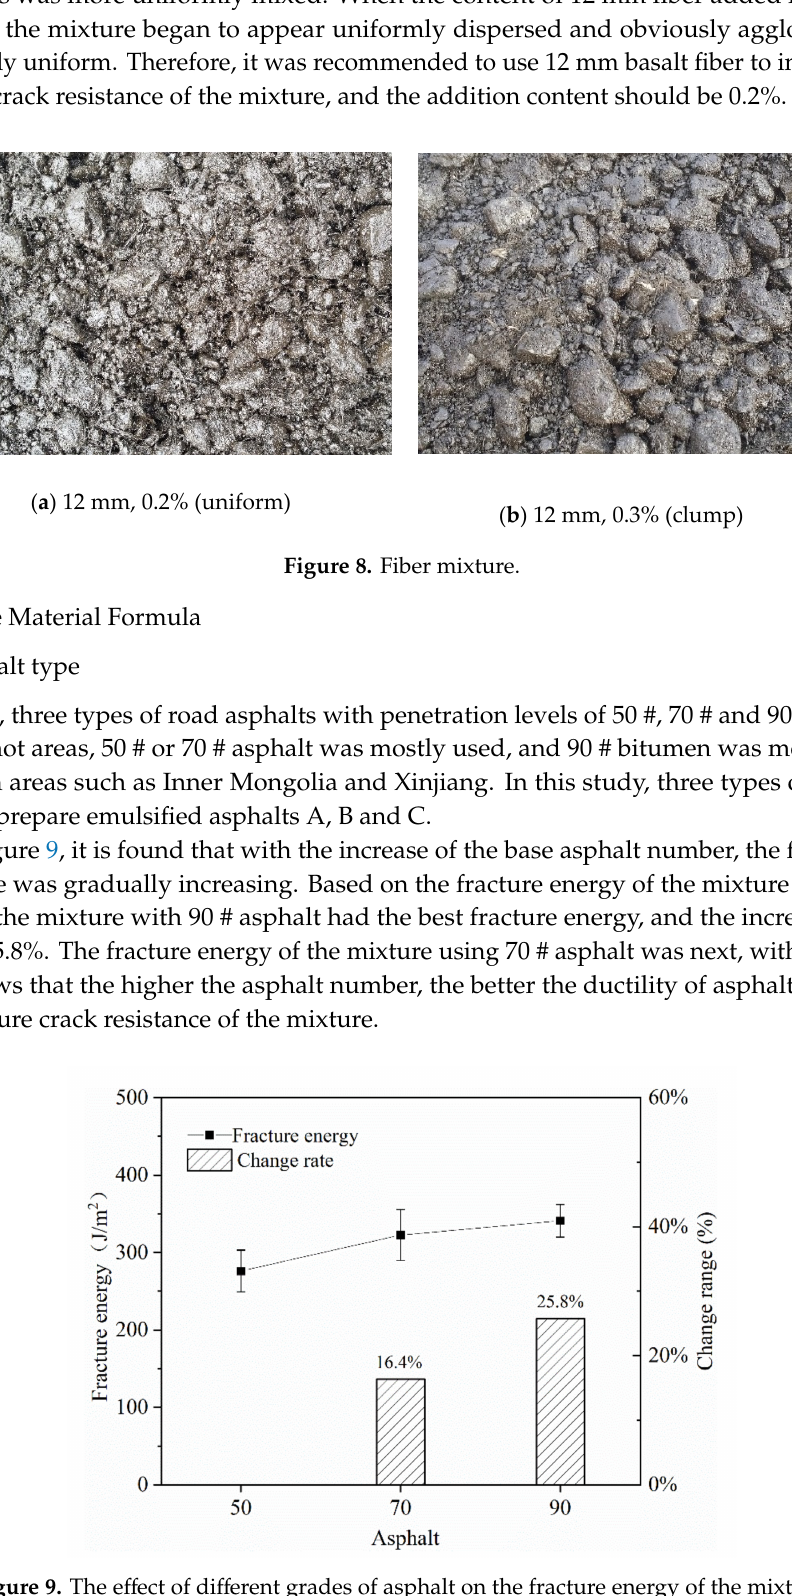
Figure 7. The influence of fiber on fracture energy.